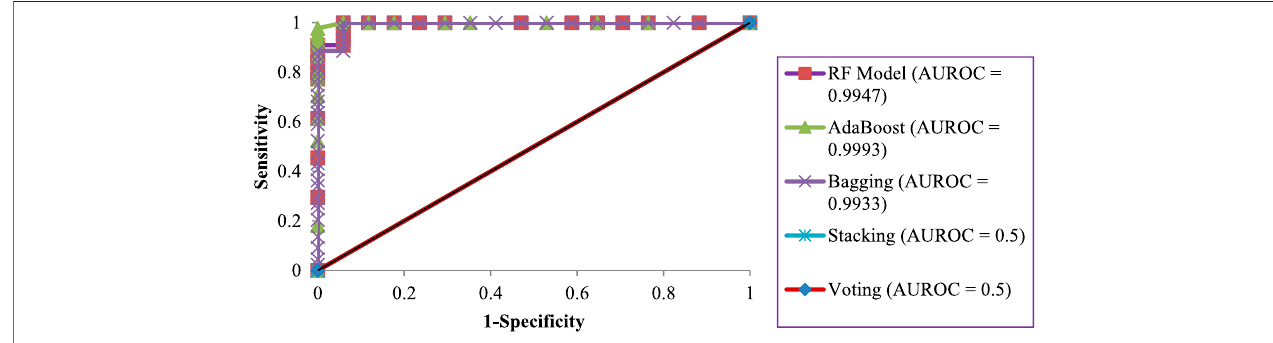
FIGURE 4 | ROC curves for ensemble ML techniques in the training dataset.